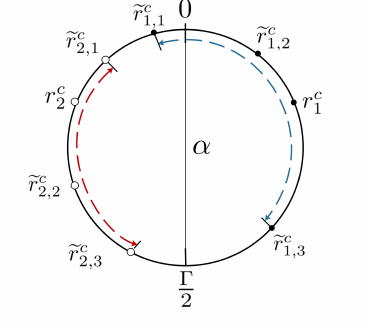
Figure 1. Illustration of the